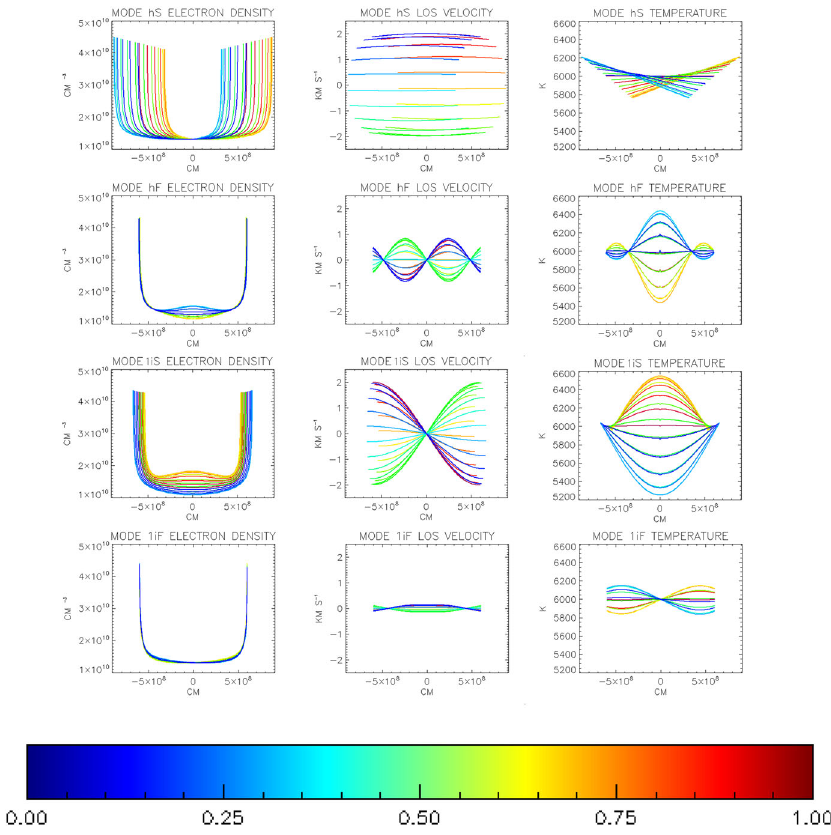
Fig. 60 MHD plus radiative transfer model: spatial and temporal variation of the total density, line-of-sight (LOS) velocity and total temperature associated to four selected magnetoacoustic modes. The horizontal axis gives the transverse position, with the unperturbed prominence plasma in the range − 5 × 10 8 cm ≤ x ≤ 5 × 10 8 cm. The time of each curve is given by the corresponding oscillatory phase, colour-coded by the bar at the bottom of the plot. Image reproduced with permission from Zapiór et al. (2016), copyright by AAS Table 1 Possibility of detecting the hS, 1iS, hF and 1iF wave modes using the Doppler velocity ( v D ), FWHM and line intensity ( I max ) of the H α and H β spectral